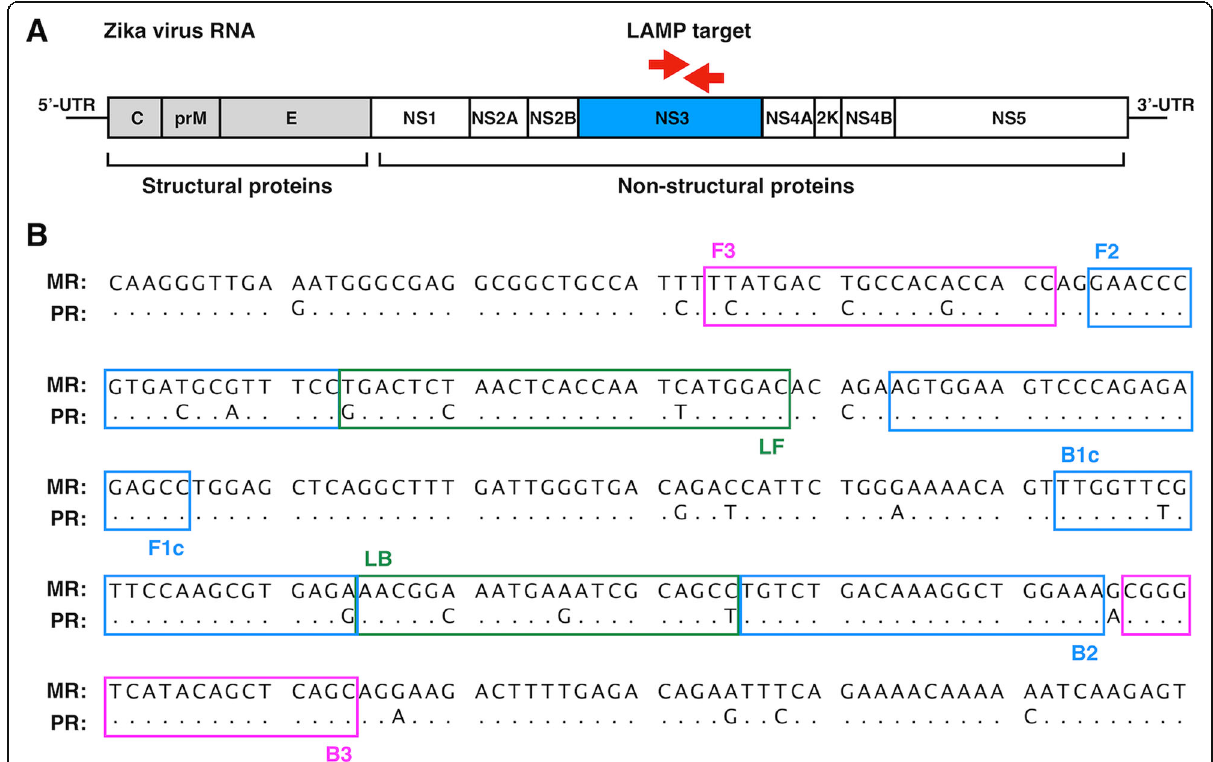
Fig. 1 Primer set for RT-LAMP targeting ZIKV MR and PR strains. a Schematic diagram of the genome region of ZIKV. The region between the two red arrows indicates the target sequence of RT-LAMP. b Partial sequence of the ZIKV NS3 region of the MR and PR strains. The primer set was designed to amplify both target sequences of the MR and PR strains. The location of each primer, FIP (F1c-F2), BIP (B1c-B2), F3, B3, Loop-F, and Loop-B, is indicated by a